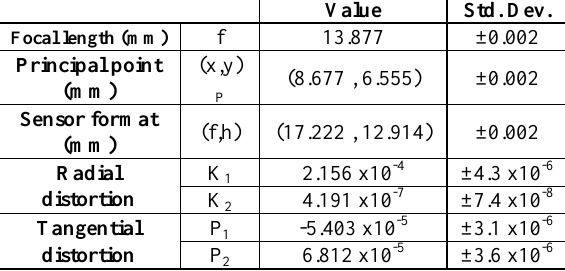
Table 3. Olympus E-P1: Camera calibration